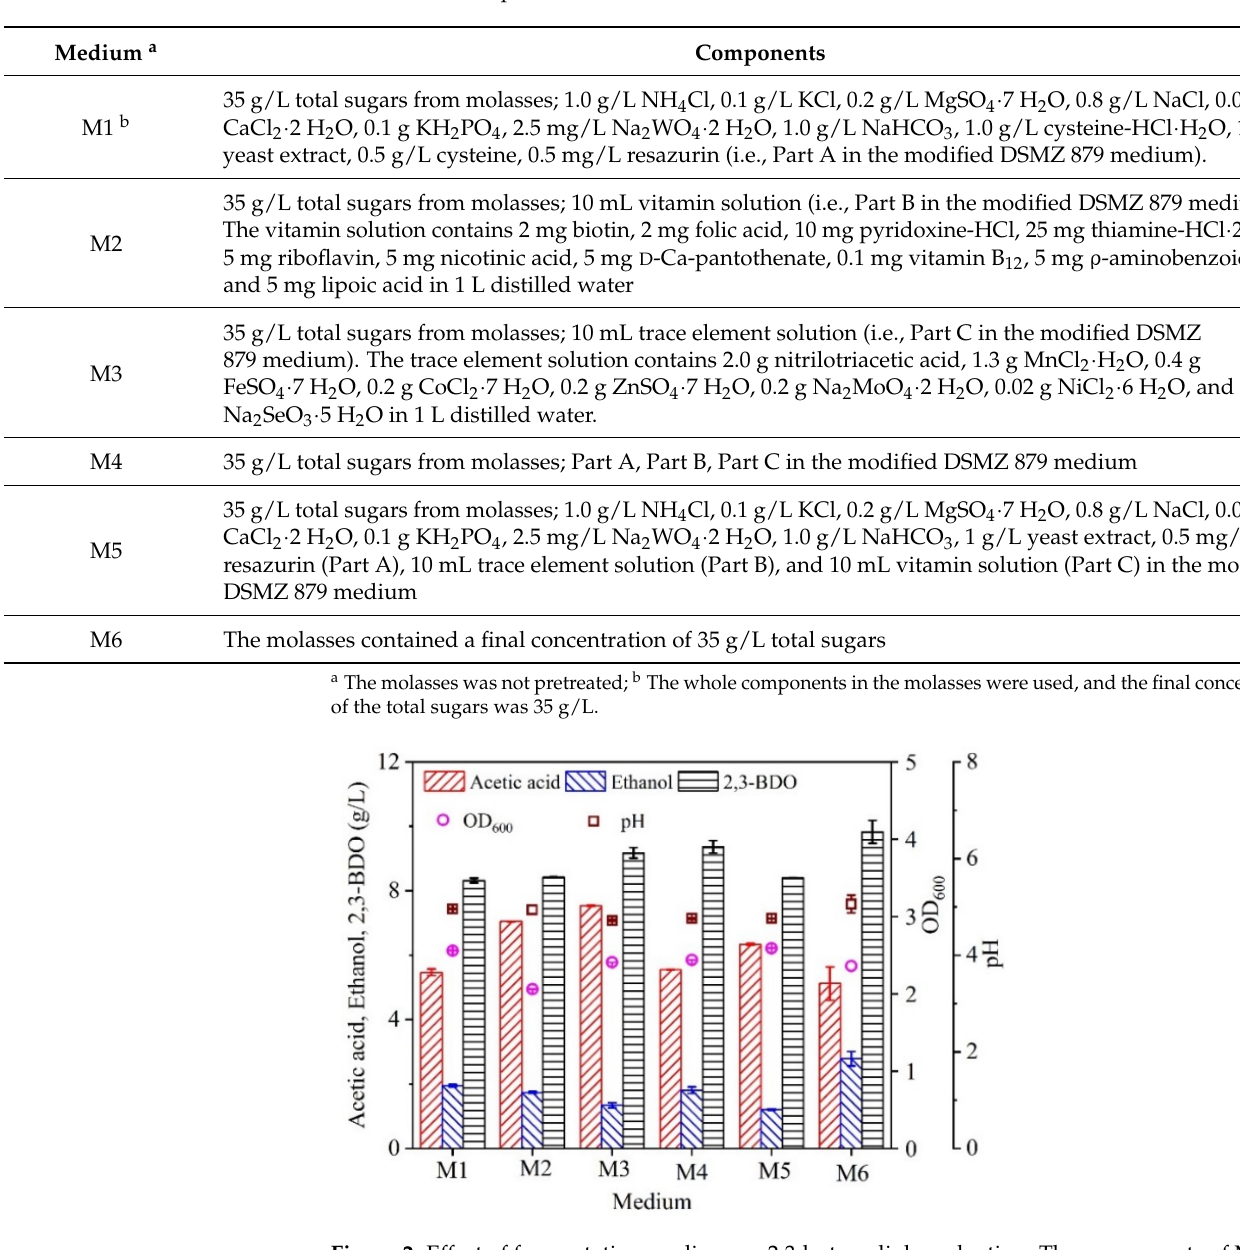
Figure 2. Effect of fermentation medium on 2,3-butanediol production. The components of M1, M2, M3, M4, M5, and M6 were shown in Table 1. The fermentations were carried out in 250 mL screw-cap bottles. Data are given as the mean ± SD, n = 3. Table 1. The components of M1, M2, M3, M4, M5, and M6.